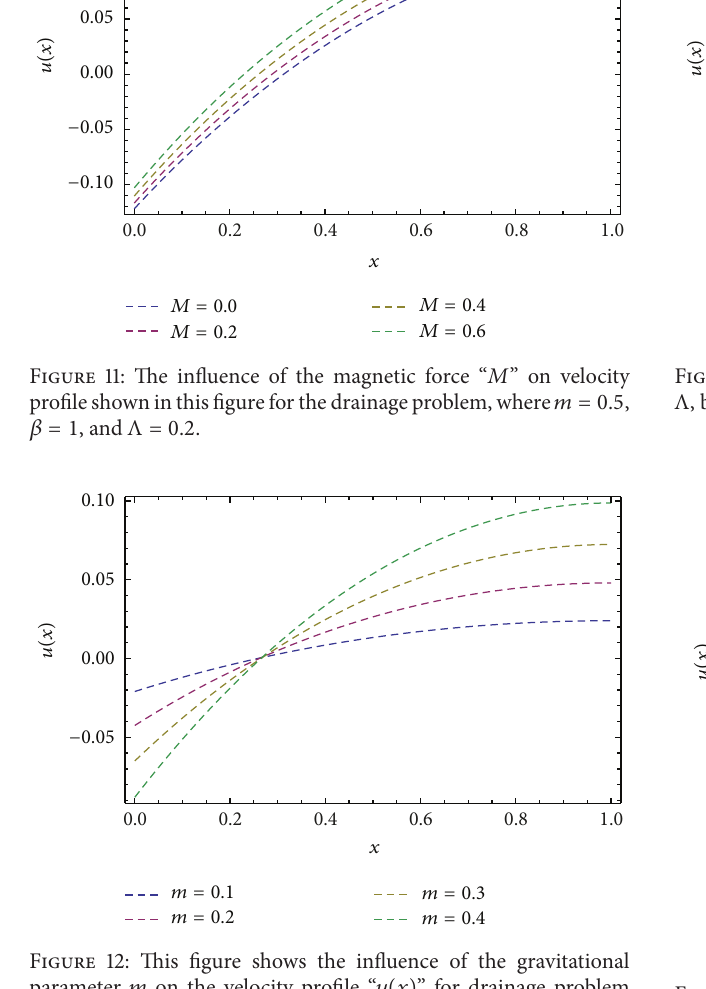
Figure 14: The influence of dimensionless number “ 𝜆 ” on the temperature distribution 𝑢(𝑥) , for drainage problem keeping 𝑚 = 0.5 , 𝑀 = 1 , Λ = 0.4 , and 𝛽 = 1 .